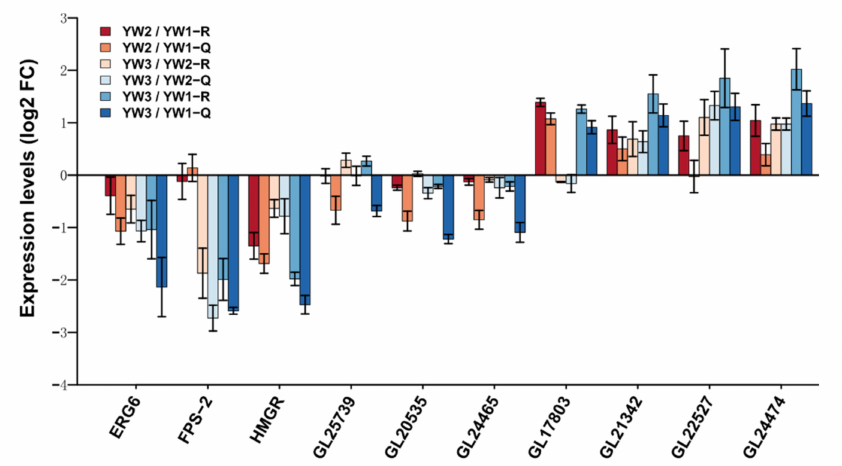
Figure 6. Expression level of selected genes in different developmental stages analyzed by qRT-PCR. qRT-PCR verification of the expression of seven differentially expressed genes (DEGs) and three non-differentially expressed genes ( GL25739 , GL20535, and GL24465 ) in three stages. Q: qRT-PCR; R: